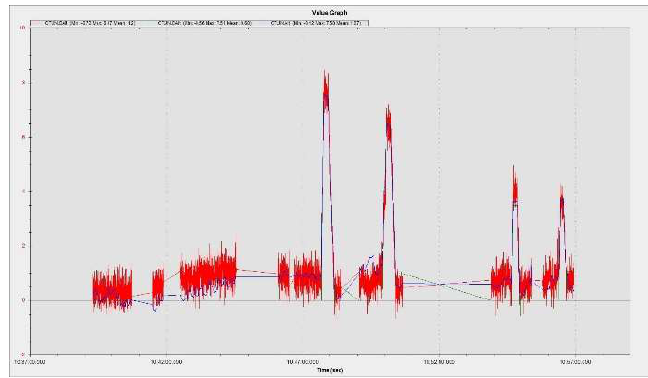
Figure 25. Hexacopter programmed and recorded altitude.